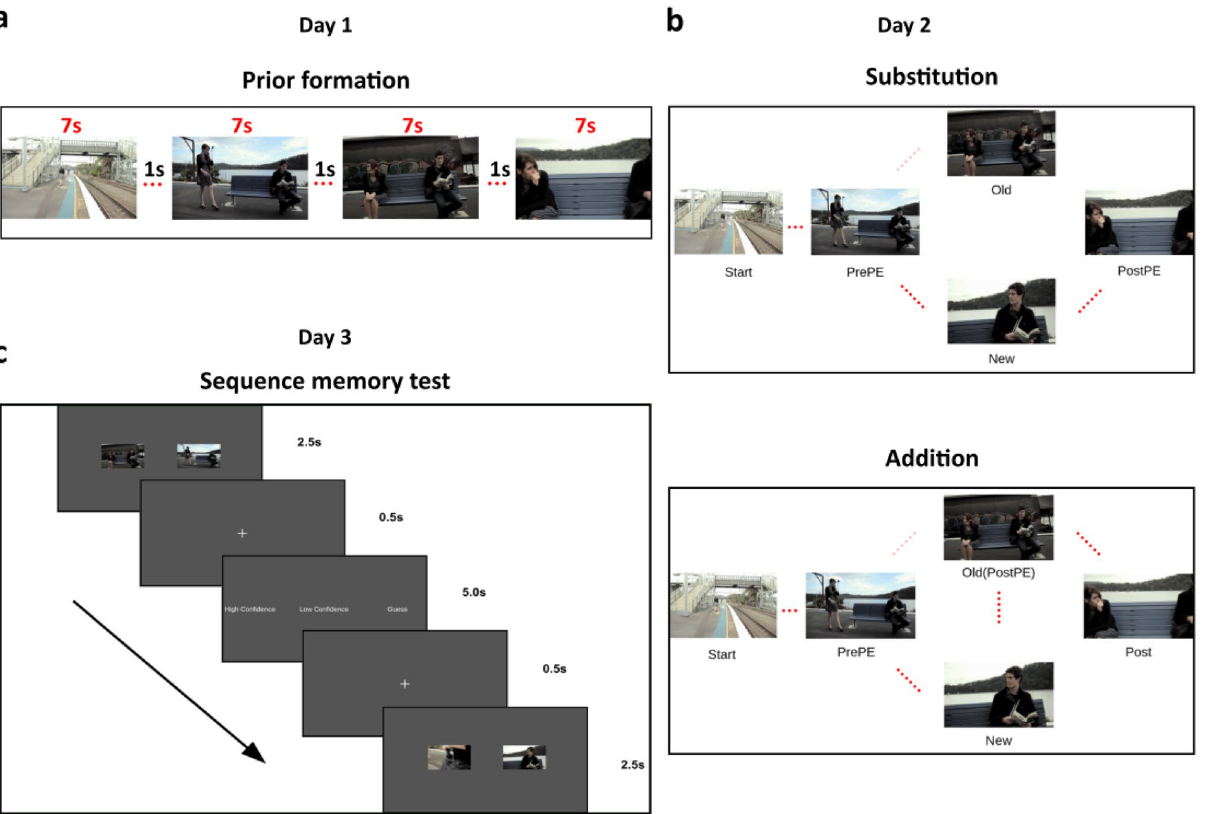
Figure 1. Experiment paradigm. Participants watched two movies (divided into several different events having multiple segments) on Day1. The following day (Day2), they saw the same movies in either two conditions— Substitution and Addition . Substitution had another contextually fitting segment substituting a prior encoded segment, while in Addition , the omitted segment is viewed again (after the prediction error). A sequence memory task (2-AFC) of adjacent segments tested participants’ temporal order memory for each event on Day3. ( a ) Example of an event seen on Day1. Each segment is 7 s with a 1 s blank screen in between (not shown). ( b ) Day2 conditions. Substitution (top) where participants were predicting a segment (Old) seen the previous day (faded red dots) while the actual segment (New) is a different one which fits with the context. Addition (bottom) which has the Old (predicted) segment re-experienced (hence reactivated) after the New segment induces the prediction error. PrePE-Old temporal sequence memory is taken as Old sequence and PrePE-New temporal sequence is taken as New sequence. ( c ) Schematic of Day3 Sequence memory test block. Each sequence was shown by displaying representative screenshots of those segments involved (in both normal and reverse order). Participants had to choose the correct order of the segments in the order they saw in the